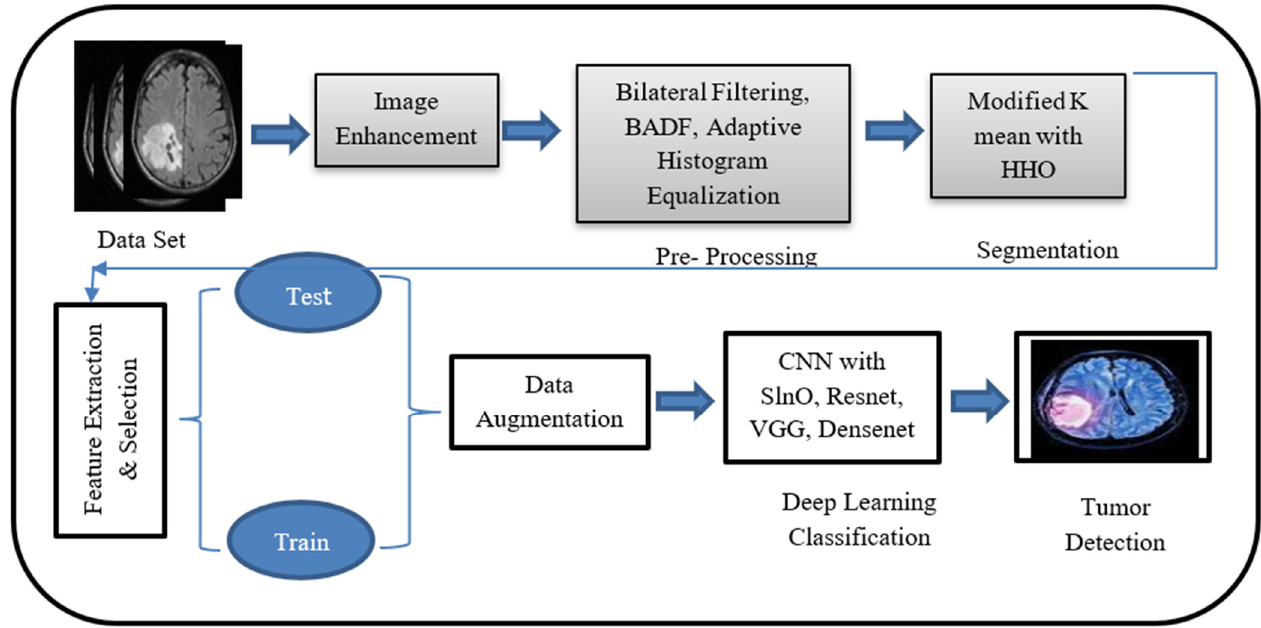
Figure 1. Schematic representation of the proposed research study. Table 2. Different sources of data and techniques of acquisition.